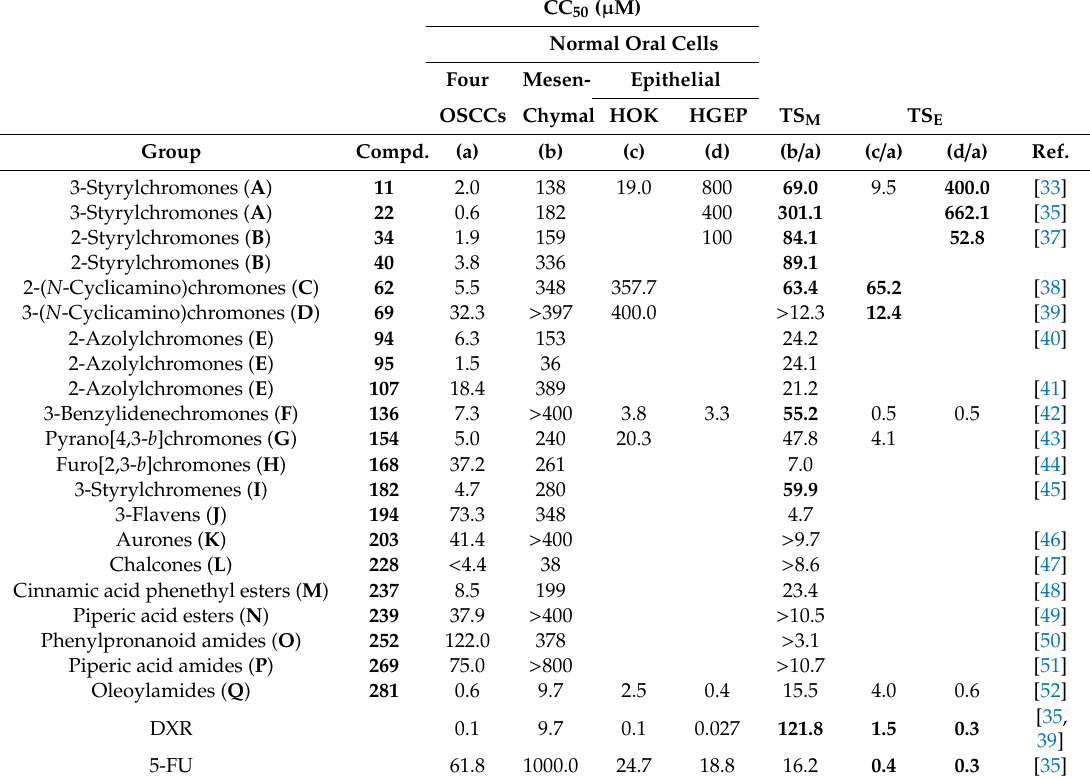
Table 5. Tumor specificity and keratinocyte toxicity of chromones and anticancer